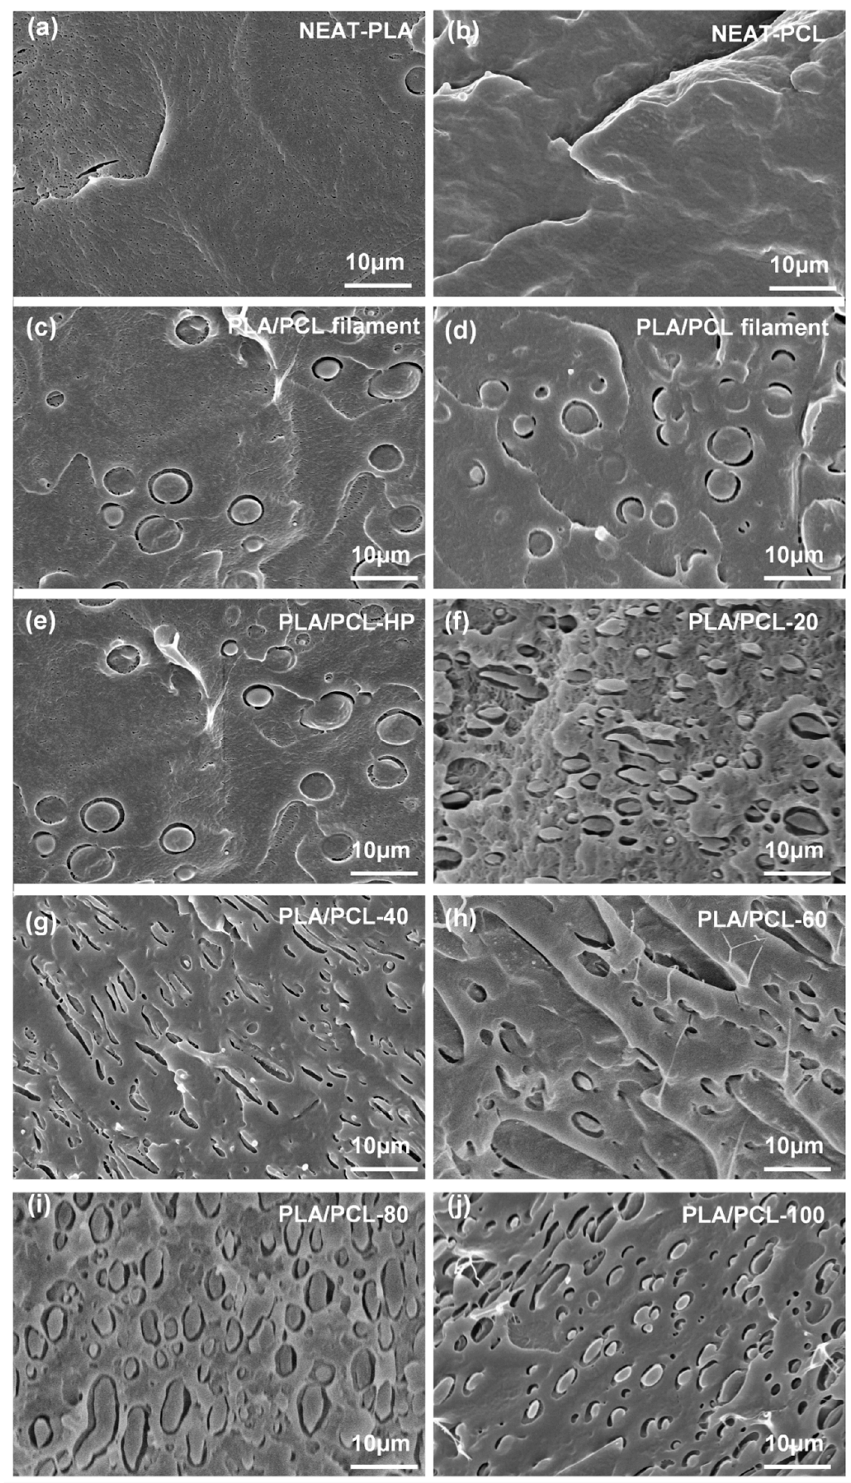
Figure 2. SEM images of ( a ) NEAT-PLA, ( b ) NEAT-PCL, ( c ) PLA/PCL filament along the extrude direction and ( d ) perpendicular to the extrude direction, ( e ) PLA/PCL-HP, ( f ) PLA/PCL-20, ( g ) PLA/PCL-40, ( h ) PLA/PCL-60, ( i ) PLA/PCL-80, and ( j ) PLA/PCL-100 samples.